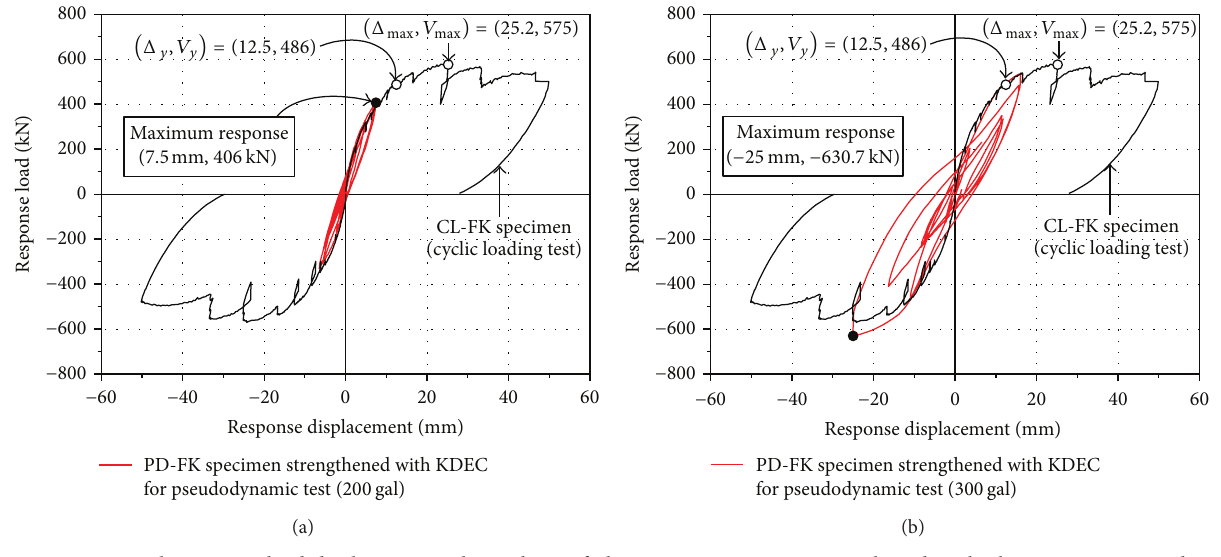
Figure 16: Lateral response load-displacement relationships of the PD-FK specimen strengthened with the KDEC system during pseudodynamic test: (a) 200 gal and (b) 300